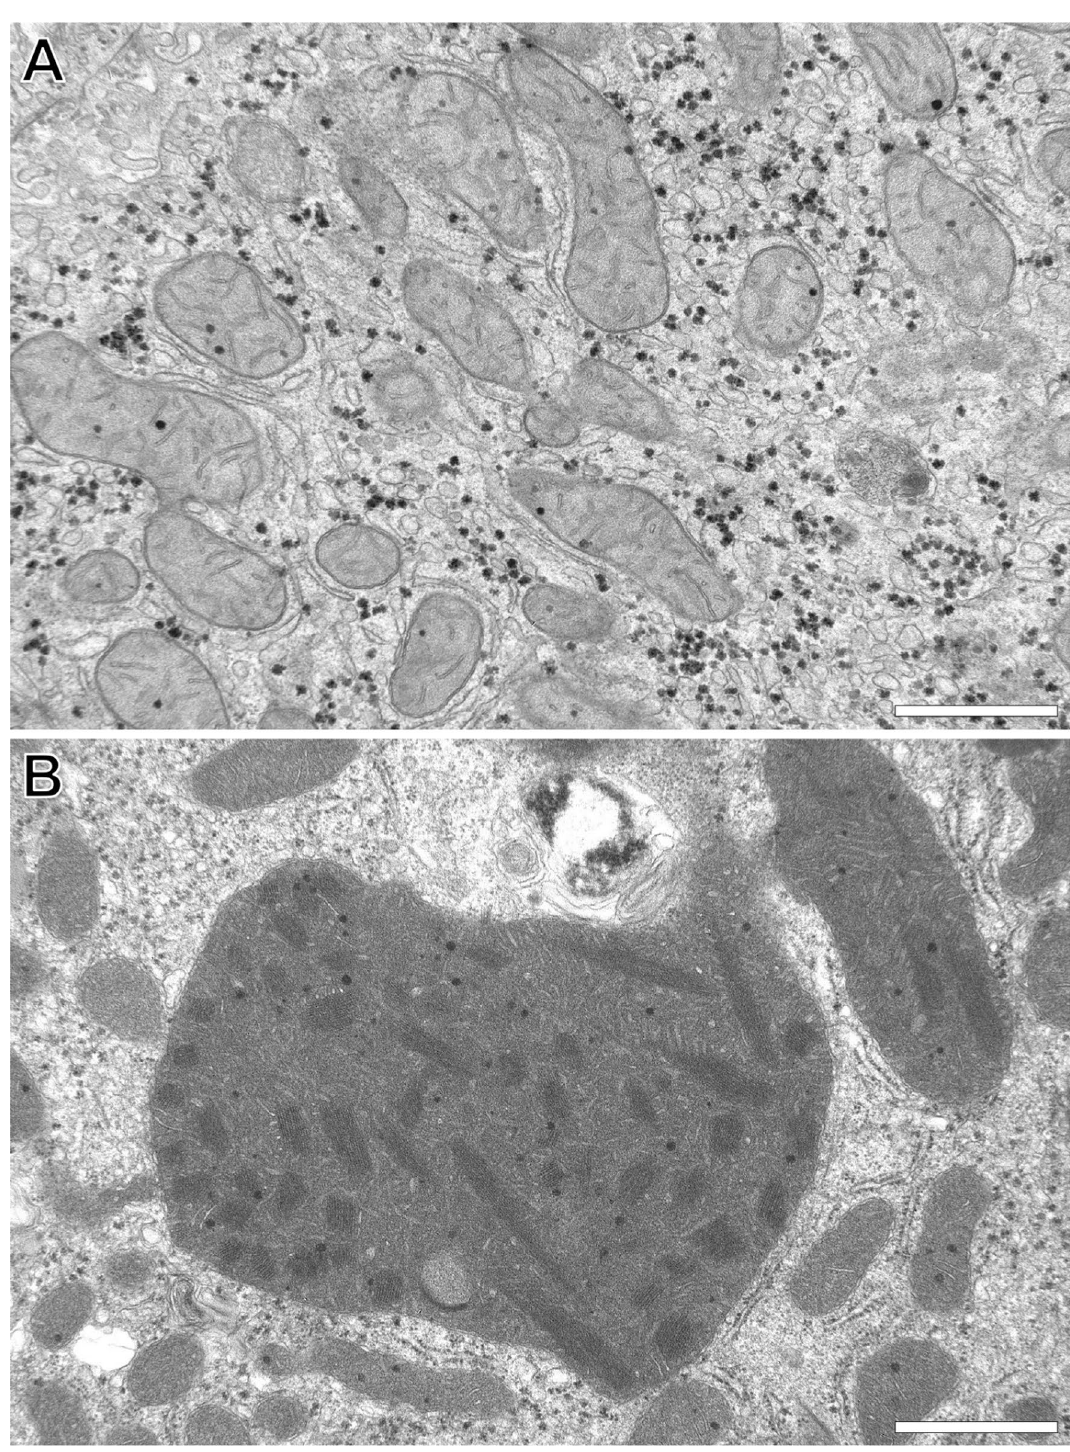
Figure 1. Representative transmission electron microscopy images of human liver parenchymal mitochondria. ( A ) Reveals normal-shaped and -size mitochondria versus ( B ) which shows a giant mitochondrion that is many times larger relative to normal mitochondria and displays a distinctly altered internal fine structural appearance. Images were obtained from ultrathin sections of injection-fixed wedge biopsies and captured in two-dimensions at intermediate magnification (19,000×) through the use of conventional transmission electron microscopy. Scale bar = 1